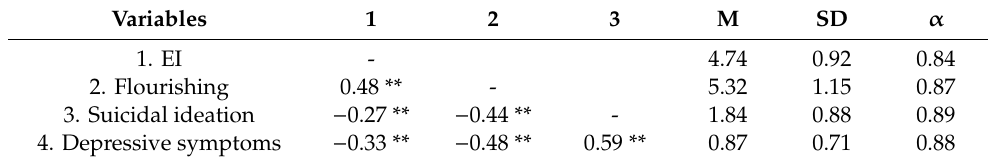
Table 1. Means, standard deviations, reliabilities, and correlations of the variables of interest.